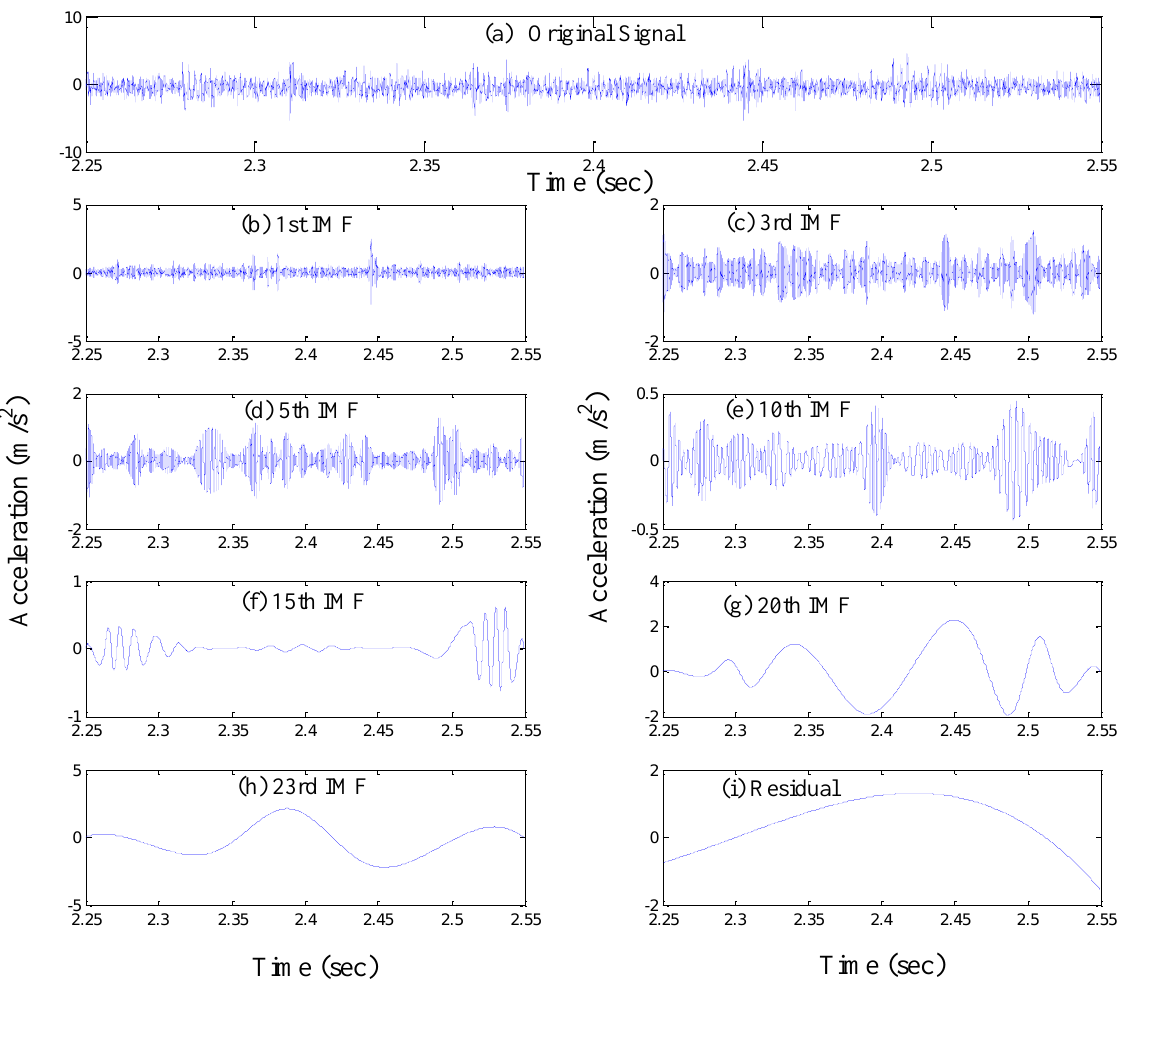
Figure 2. Acceleration measurements of a roller bearing with ( a ) inner-race defect, and ( b )–( i ) representative IMFs, after decomposition through